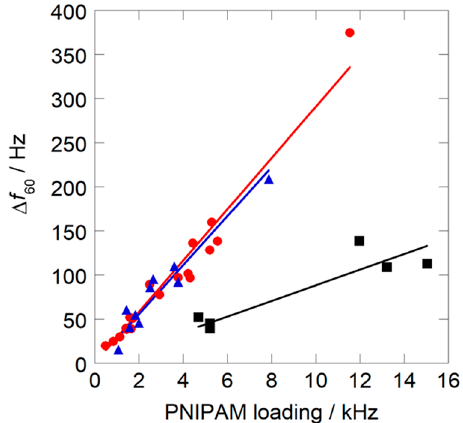
Figure 6. Dependence of the magnitude of the sensor response on PNIPAM loadings measured at 30 °C: ( ● ) X M = 0.2; ( ▲ ) X M = 0.3; ( ■ ) X M = 0.